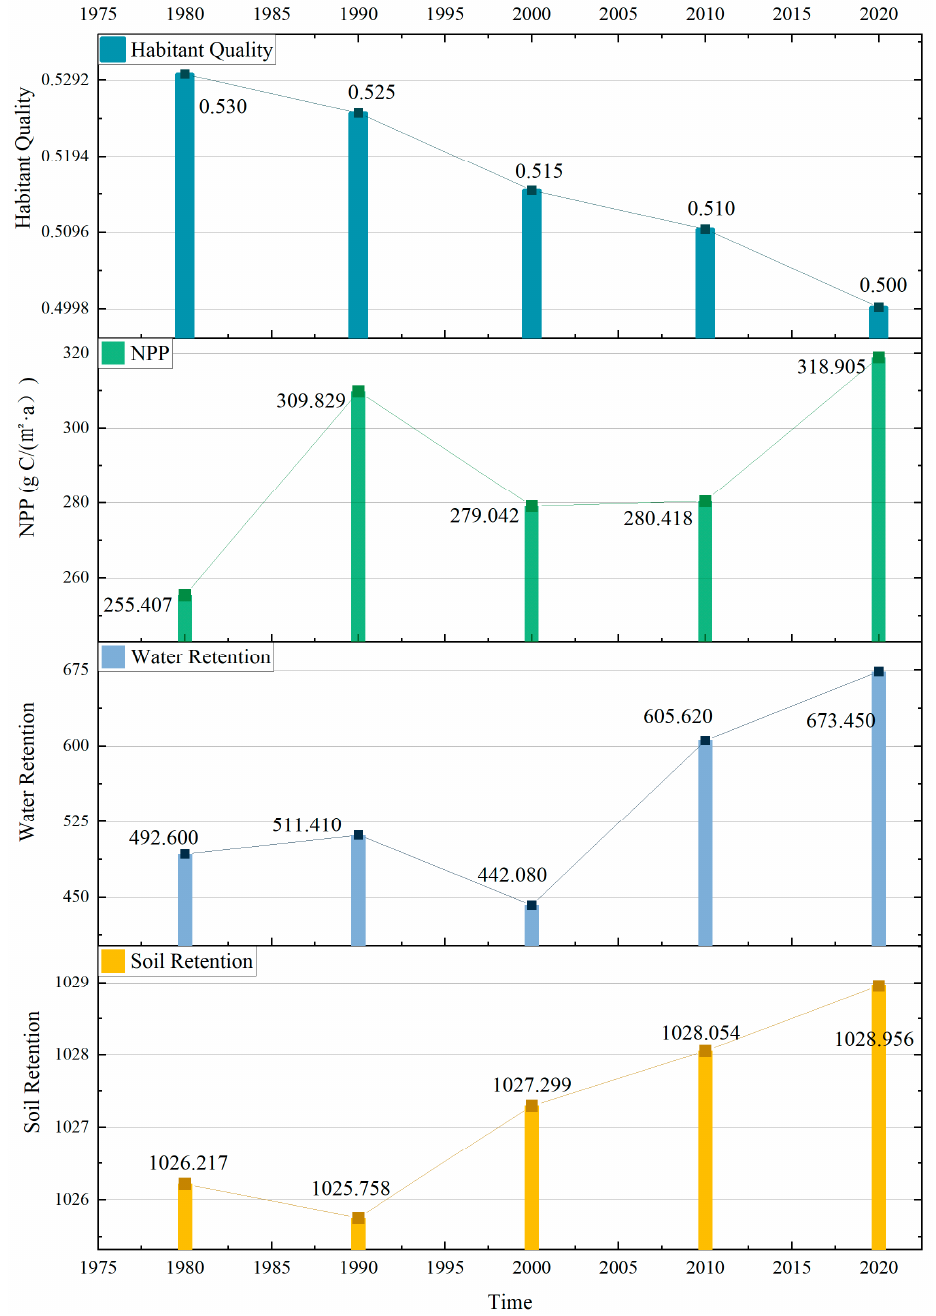
Figure 8. Analysis of the change in types of ecosystem services in the Yang tz e River Delta from 1980 to 2020. 1980 to